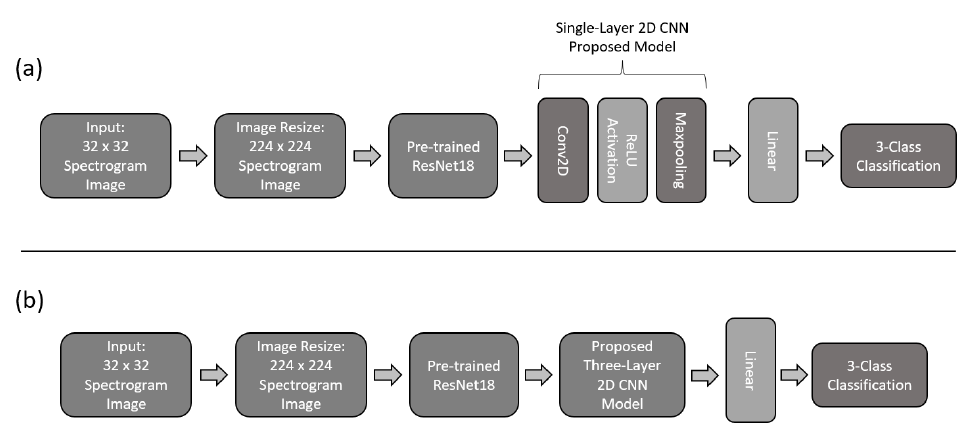
Figure 14. Basic architecture of transfer learning model, using ResNet18’s body. ( a ) Illustrates the implemented model with the devised single-layer models as a tail for the 3-class classification task of MI; ( b ) Illustrates the implemented model with the devised three-layer models as a tail for the 3-class classification task of MI.